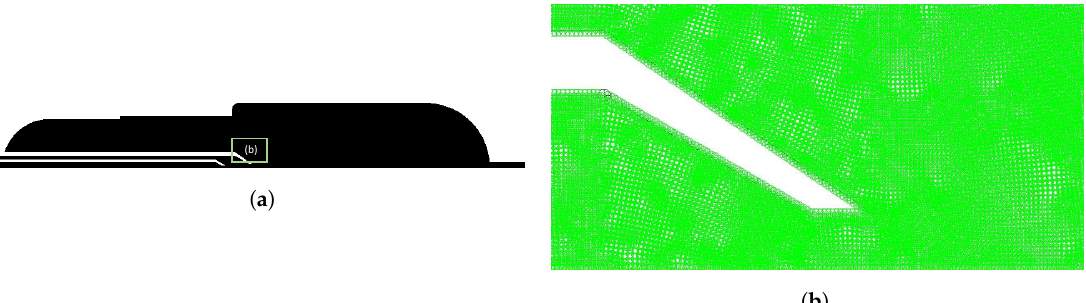
Figure 4. Mesh ( a ) from entire model and ( b ) a close-up of the critical